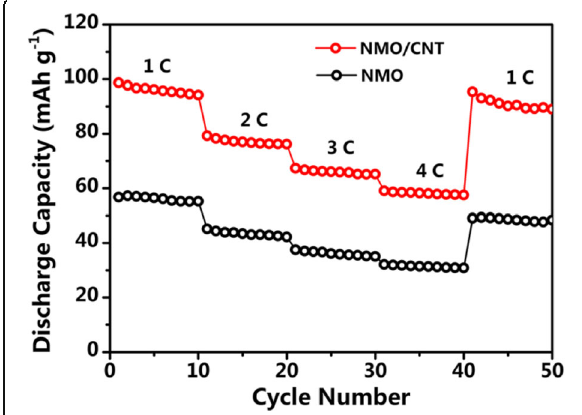
Fig. 6 Rate performances of NMO and NMO/CNT electrodes from 1 to 4 C